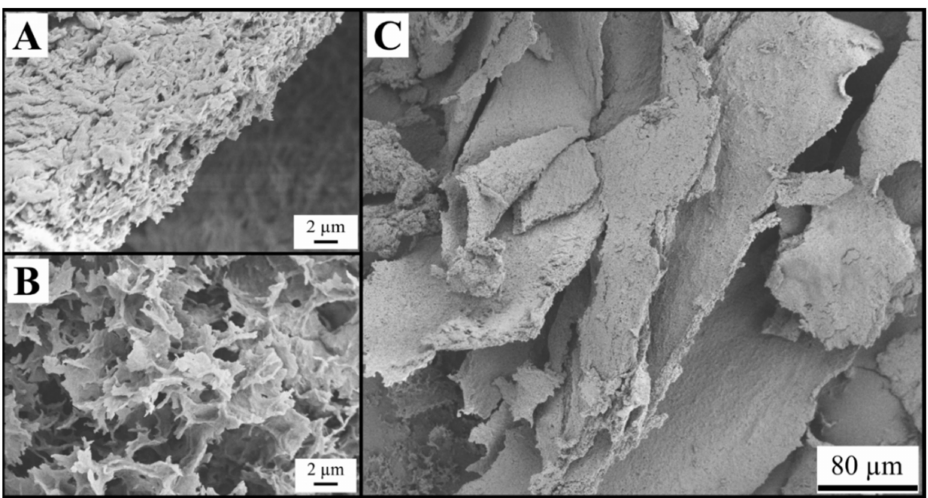
Figure 5. Partially porous structure of the sample FD-G-LN derived from 5 wt.% starch suspension and freeze-dried at sublimation pressure of 0.045 mbar. Picture ( C ) shows an overview of the material structure. Pictures ( A , B ) correspond respectively to a pore wall with apparent porosity and a region with smaller pores observed with higher magnifications.